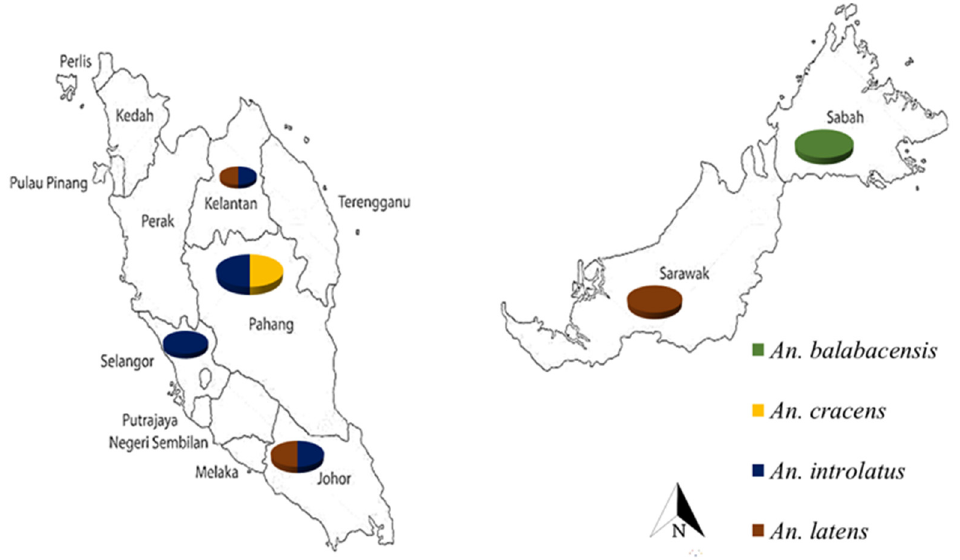
Figure 1. Mosquito sampling sites by species collected from Peninsular Malaysia and Malaysian Borneo (Sabah and Sarawak).